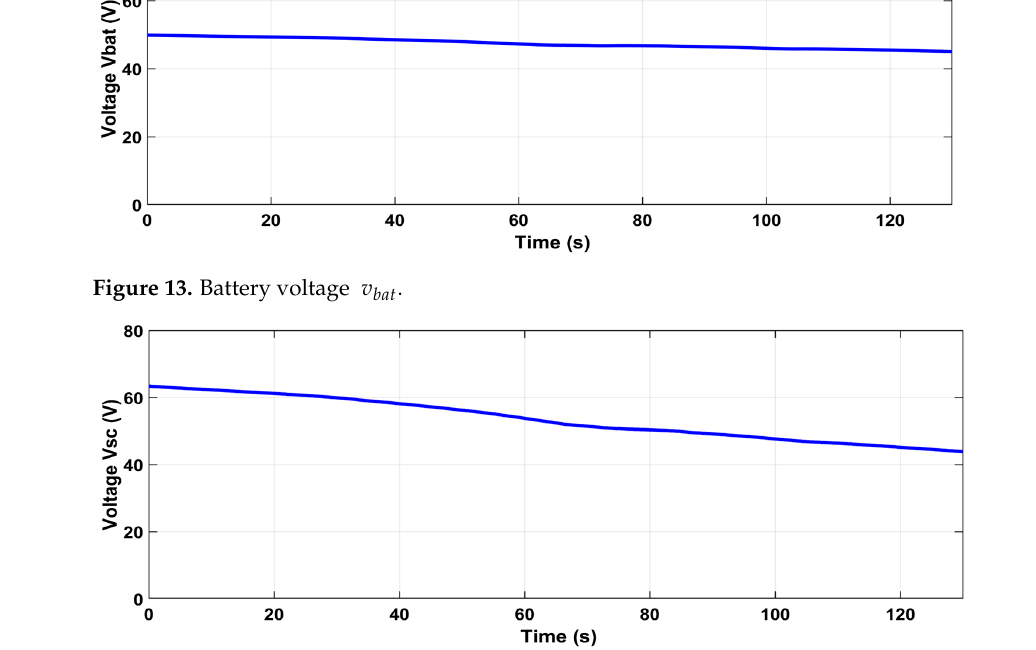
Figure 14. Supercapacitor voltage 𝒗 𝒔𝒄 .